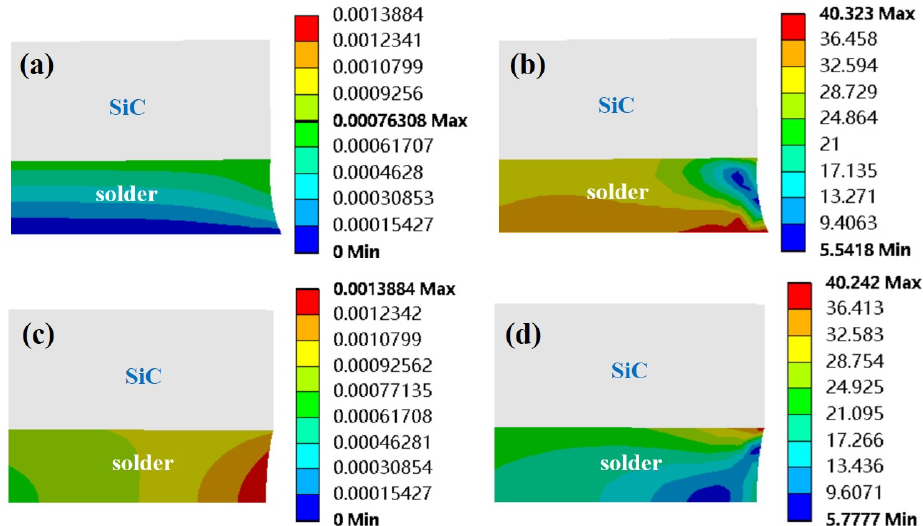
Figure 4. The ( a ) deformation contour plot and ( b ) stress contour plot of the chip–solder layer structure under the fixed constraint, and the corresponding ( c ) deformation contour plot and ( d ) stress contour plot under the non-fixed